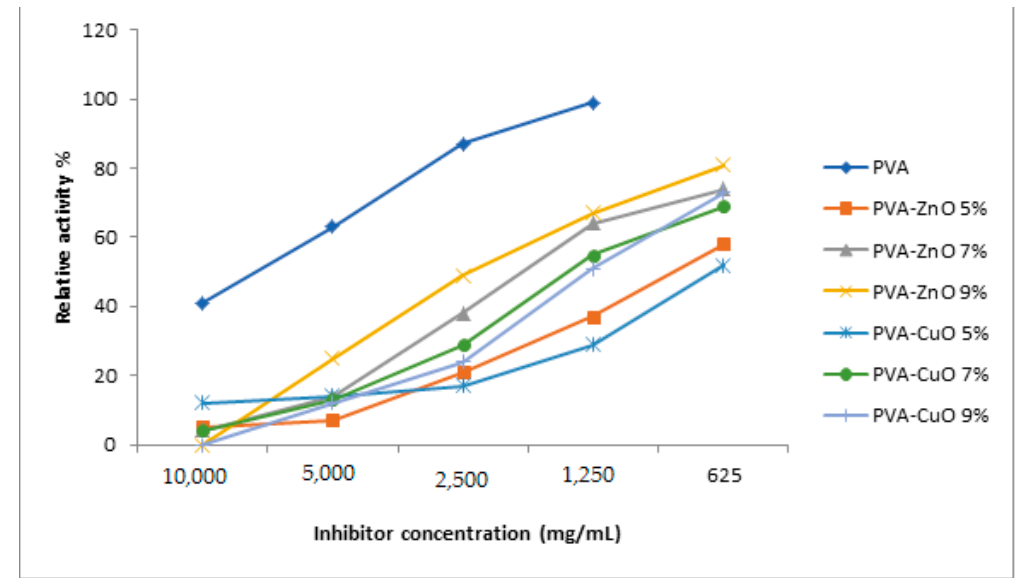
Figure 3. Remaining activity percentage of blocking viral fusion of SARS-COV-2 of the prepared nanofibers.